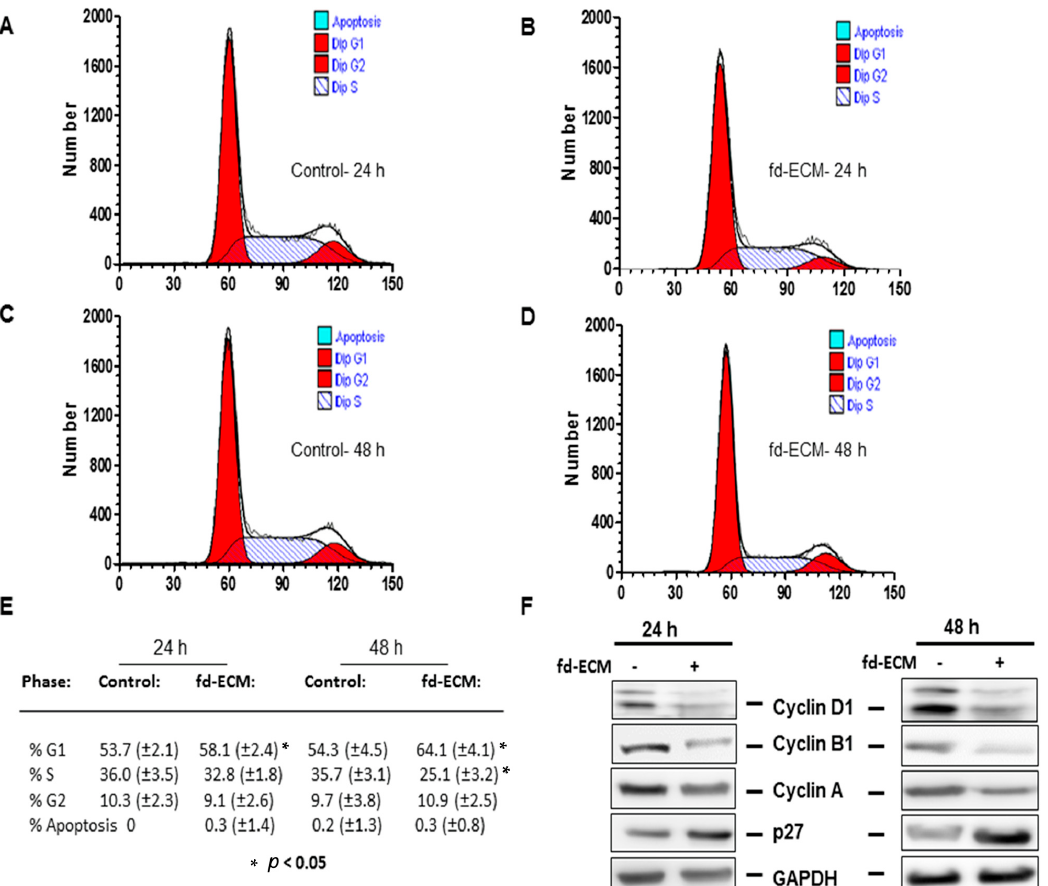
Figure 5. Fd-ECM downregulates cell cycling in ad-MSCs in vitro. Ad-MSCs were cultured on plastic dishes ( − ) or on fd-ECM (+) for the indicated time periods ( A ) Flow cytometric analysis of control ad-MSCs showed no apparent apoptosis after 24 h of incubation; ( B ) Ad-MSCs were cultured on fd-ECM for 24 h and cell cycle analysis was done by flow cytometry after labeling ad-MSCs with propidium iodide; ( C ) Ad-MSCs were cultured on tissue plastic dishes for 48 h, labeled with propidium iodide for flow cytometric analysis; ( D ) Ad-MSCs were cultured on fd-ECM for 48 h and flow cytometric analysis was done as described above; ( E ) Ad-MSCs (%) in each cell cycle stage after ad-MSCs were cultured on plastic and on fd-ECM for 24 and 48 h. Four different experiments were pooled. Results show mean ± standard deviation; and ( F ) Fd-ECM reduces cycling in ad-MSCs. Immunoblot analysis of cyclin D1, cyclin B1, cyclin A, and p27 in ad-MSCs lysates after culture on plastic ( − ) and fd-ECM (+) for 24 and 48 h.